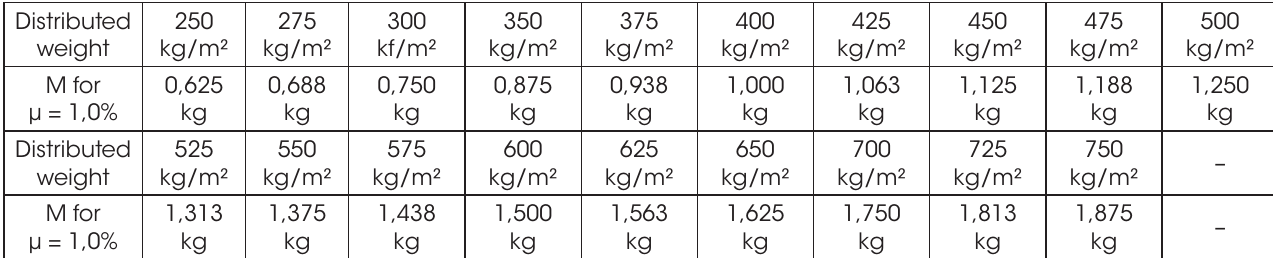
Calculated mass of the inertial elements of the TMD for the distributed weights considerer Distributed